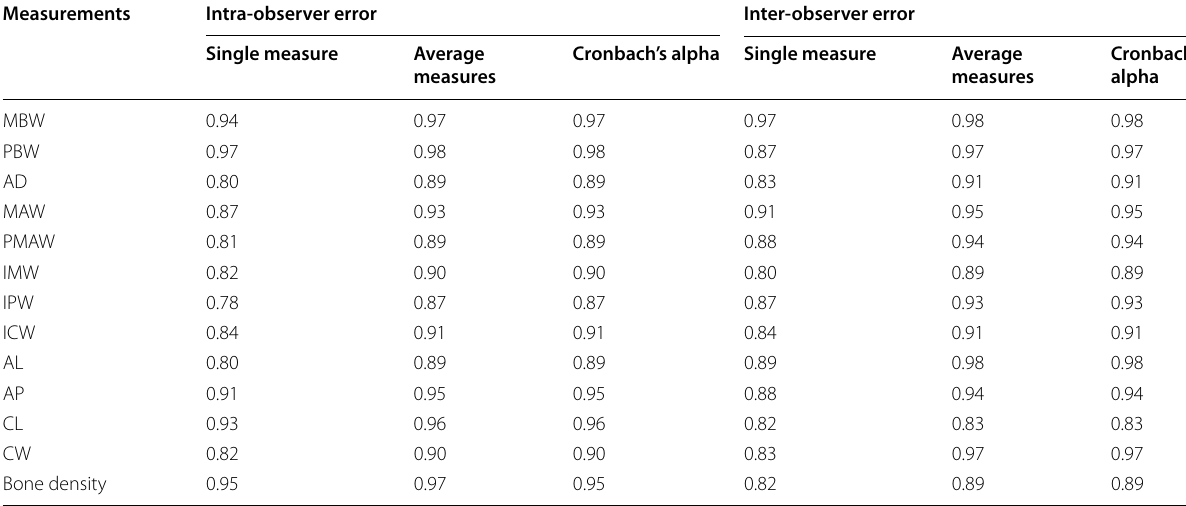
Table 4 The intra‑class correlation coefficient (ICC) for reliability